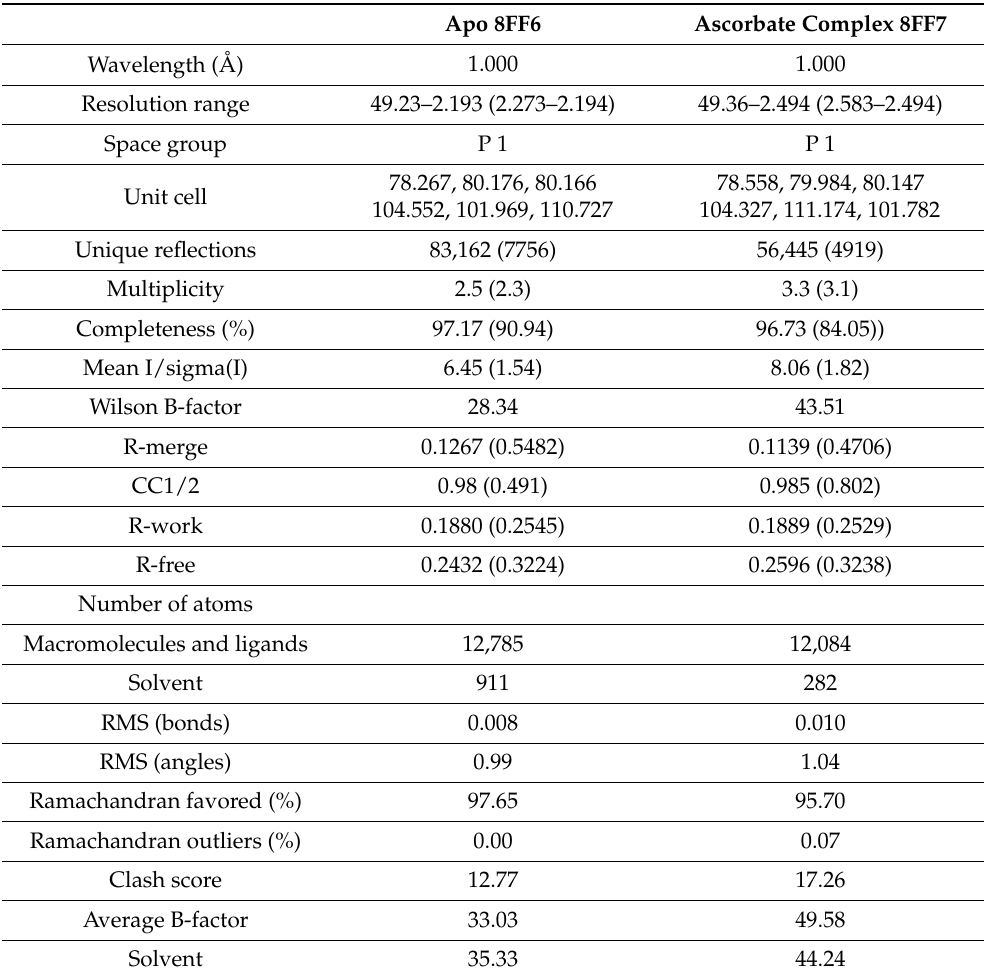
Table 1. Crystallography statistics of